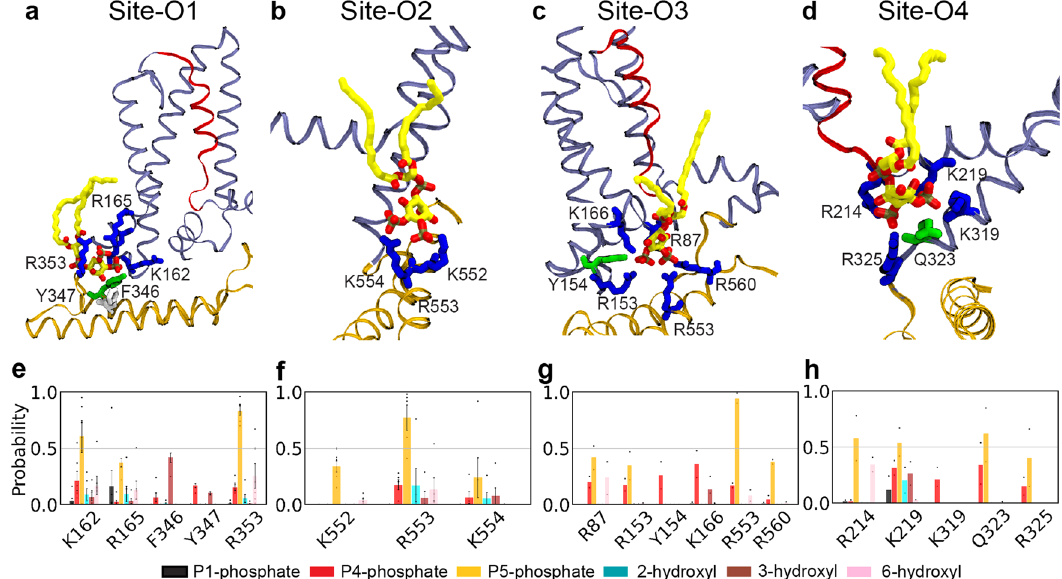
Fig. 2 PIP 2 coordination in 4 binding sites captured in the modeled structure of the open K v 7.2 channel. a – d PIP 2 coordination in Site-O1 ( a ), Site-O2 ( b ), Site-O3 ( c ), and Site-O4 ( d ). K v 7.2 protein is shown in ribbon representation with S4 in red, helices A and B in brown, and the rest of the protein in ice blue. A PIP 2 lipid (carbon atoms in yellow, oxygen in red, and phosphorus atoms in tan) and the residues of the binding pocket at each site at the end of simulations are shown in sticks (basic residues in blue, polar in green, acidic in red, and hydrophobic in white). e – h The contact probability for each chemical moiety of PIP 2 headgroup with the key residues in the binding Site-O1 ( e ), Site-O2 ( f ), Site-O3 ( g ), and Site-O4 (h). The chemical moieties of PIP 2 headgroup include P1-phosphate (black), P4-phosphate (red), P5-phosphate (orange), 2-hydroxyl (cyan), 3-hydroxyl (brown), and 6-hydroxyl (pink) group of the inositol ring. A heavy-atom distance cutoff of 4 Å was used to de fi ne a contact between a protein residue and a phosphate group of PIP 2 , whereas a 3.5 Å cutoff was used to de fi ne a contact between a residue and a hydroxyl group of PIP 2 . Analysis of the contact probabilities was performed over the last 200 ns of the simulation trajectories. The number of PIP 2 interacting events: Site-O1 ( n = 6), Site-O2 ( n = 5), Site-O3 ( n = 2), and Site-O4 ( n = 2). Data represent mean ± SEM for analysis of each monomer in 3 independent